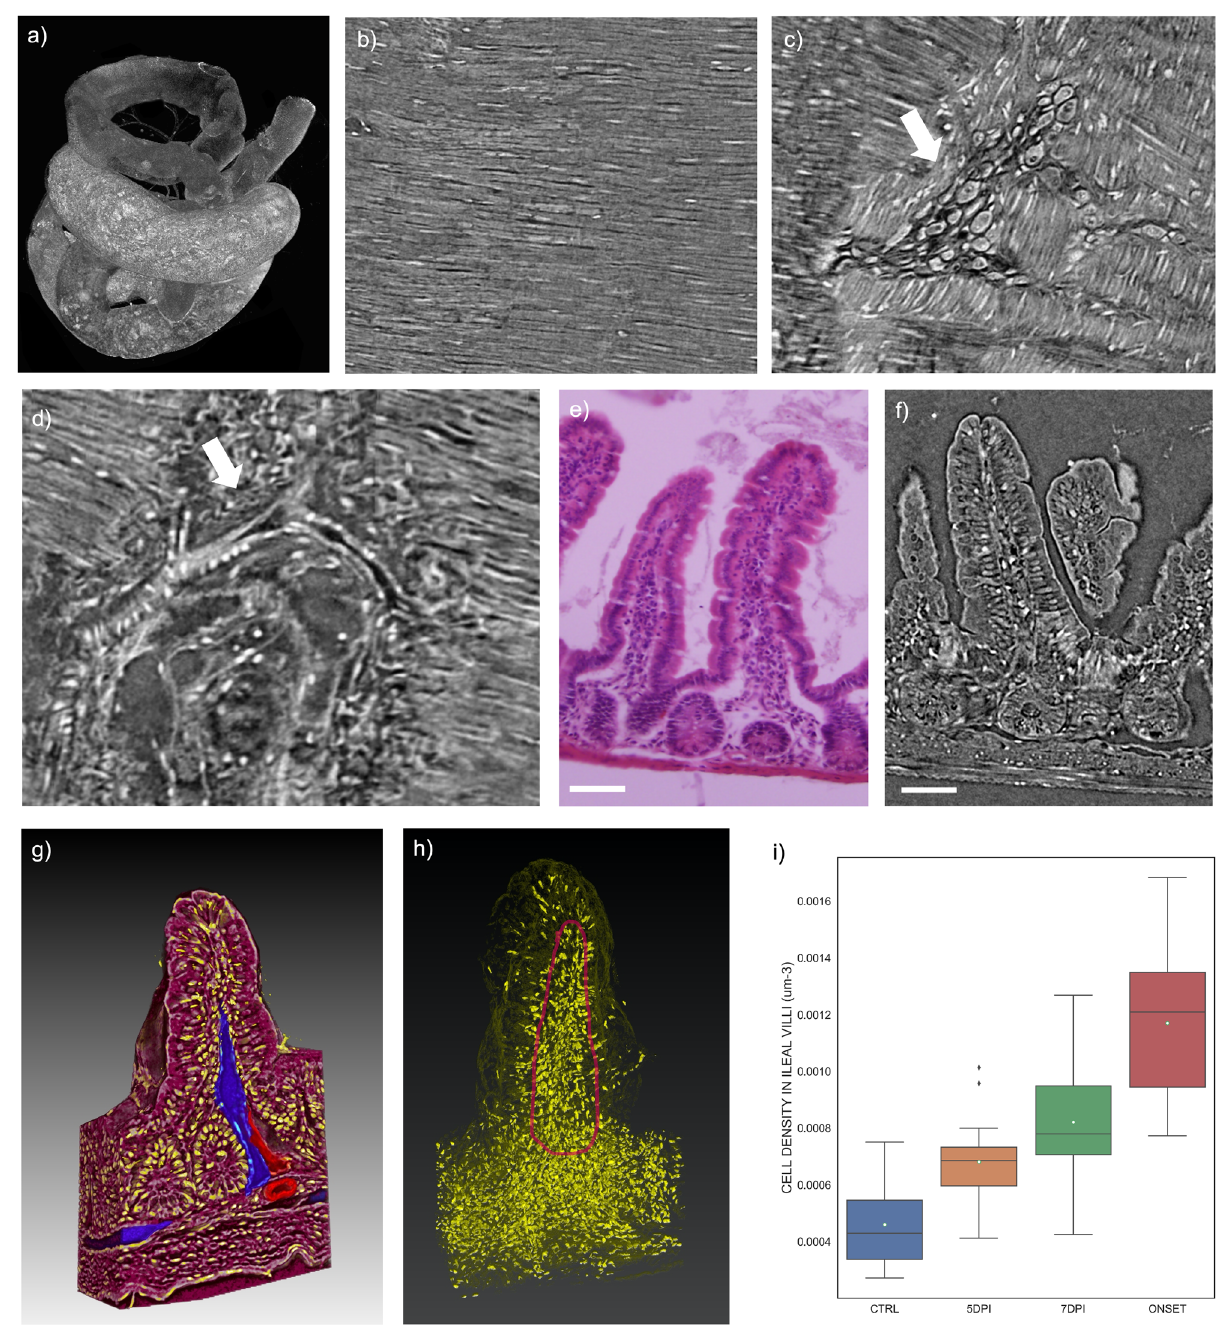
Fig. 5 Multiscale imaging of mouse gut and cell density in lamina propria of ileal villi. X-ray phase contrast tomography (XPCT) enables multiscale imaging of mouse gut with histology-like resolution and quanti fi cation of cell density in lamina propria of ileal villi. a 3D-rendering of a whole mouse gut from a naïve mouse imaged with XPCT. b – d XPCT images of the layers of gut wall obtained after virtual fl attening of the ileum of an experimental autoimmune encephalomyelitis (EAE)-affected mouse. b Tunica muscolaris; c cells compatible in size, morphology, and location with neurons of the myenteric plexus 23,24 (arrow); d vessel (arrow) running along the tela submucosa. e Hematoxylin-eosin stained histological section and f XPCT image of ileal villi of an EAE-affected mouse. The XPCT image was obtained as maximum intensity projections over 5 μ m. Scale bar = 50 μ m. g 3D-rendering form XPCT data of a villus from the ileum of an EAE-affected mouse; blood vessels are segmented in red, lymphatic canals in blue, and cells in yellow. h 3D- rendering of the cells inside the volume of a villus from the ileum of an EAE-affected mouse; the area outlined by the red line roughly corresponds to the region of the lamina propria. i Box plot of cell density calculated as the ratio of the number of cells counted in the lamina propria to the volume occupied by this structure in the villus (20 villi per n = 2 mice per time point). Mean values are indicated by white spots and outliers are presented as black spots. Clinical EAE score at the onset = 1.5. XPCT data were acquired in Experiment 2, reported in Methods.